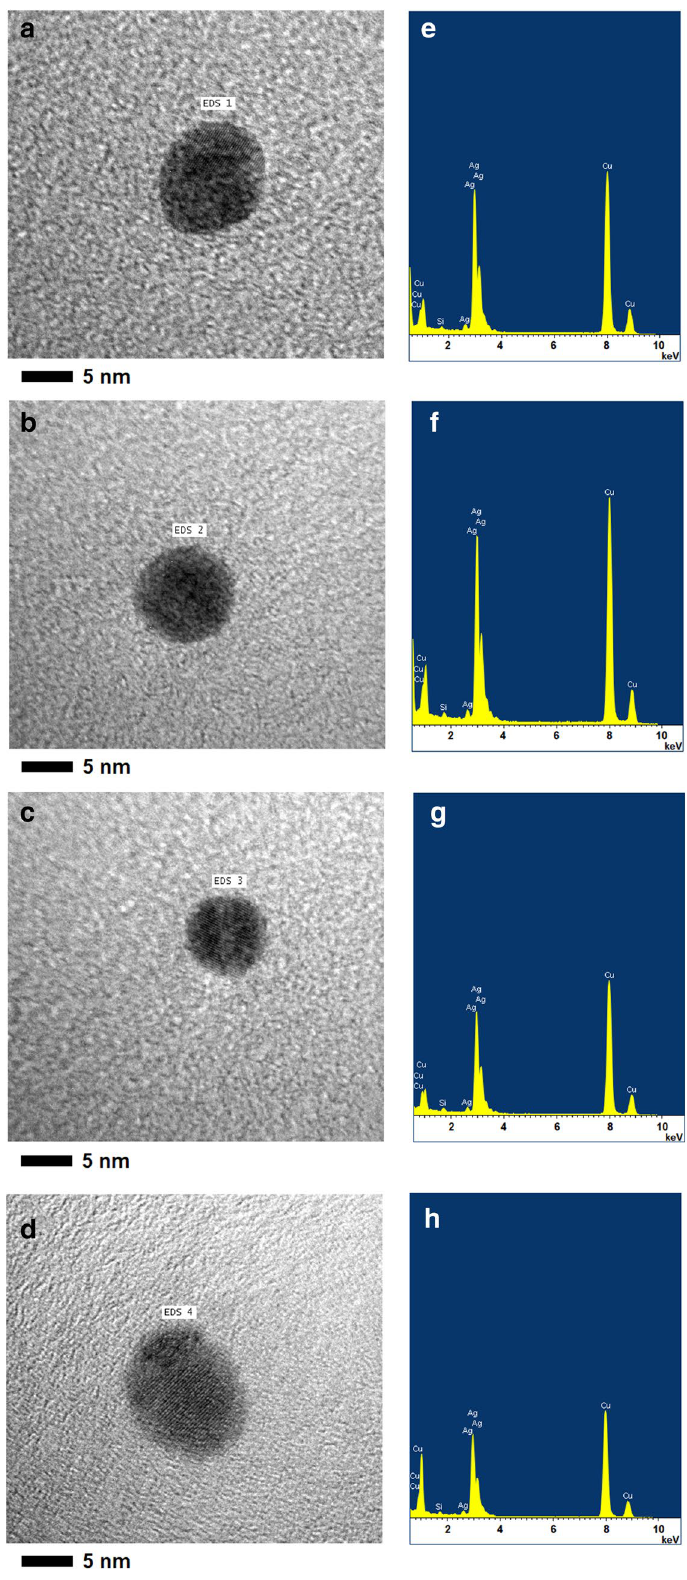
Figure 6. TEM-EDS analyses of the sub-15 nm AgNPs obtained by sonochemistry ( a – d ) HR-TEM measurements, ( e – h ) EDS